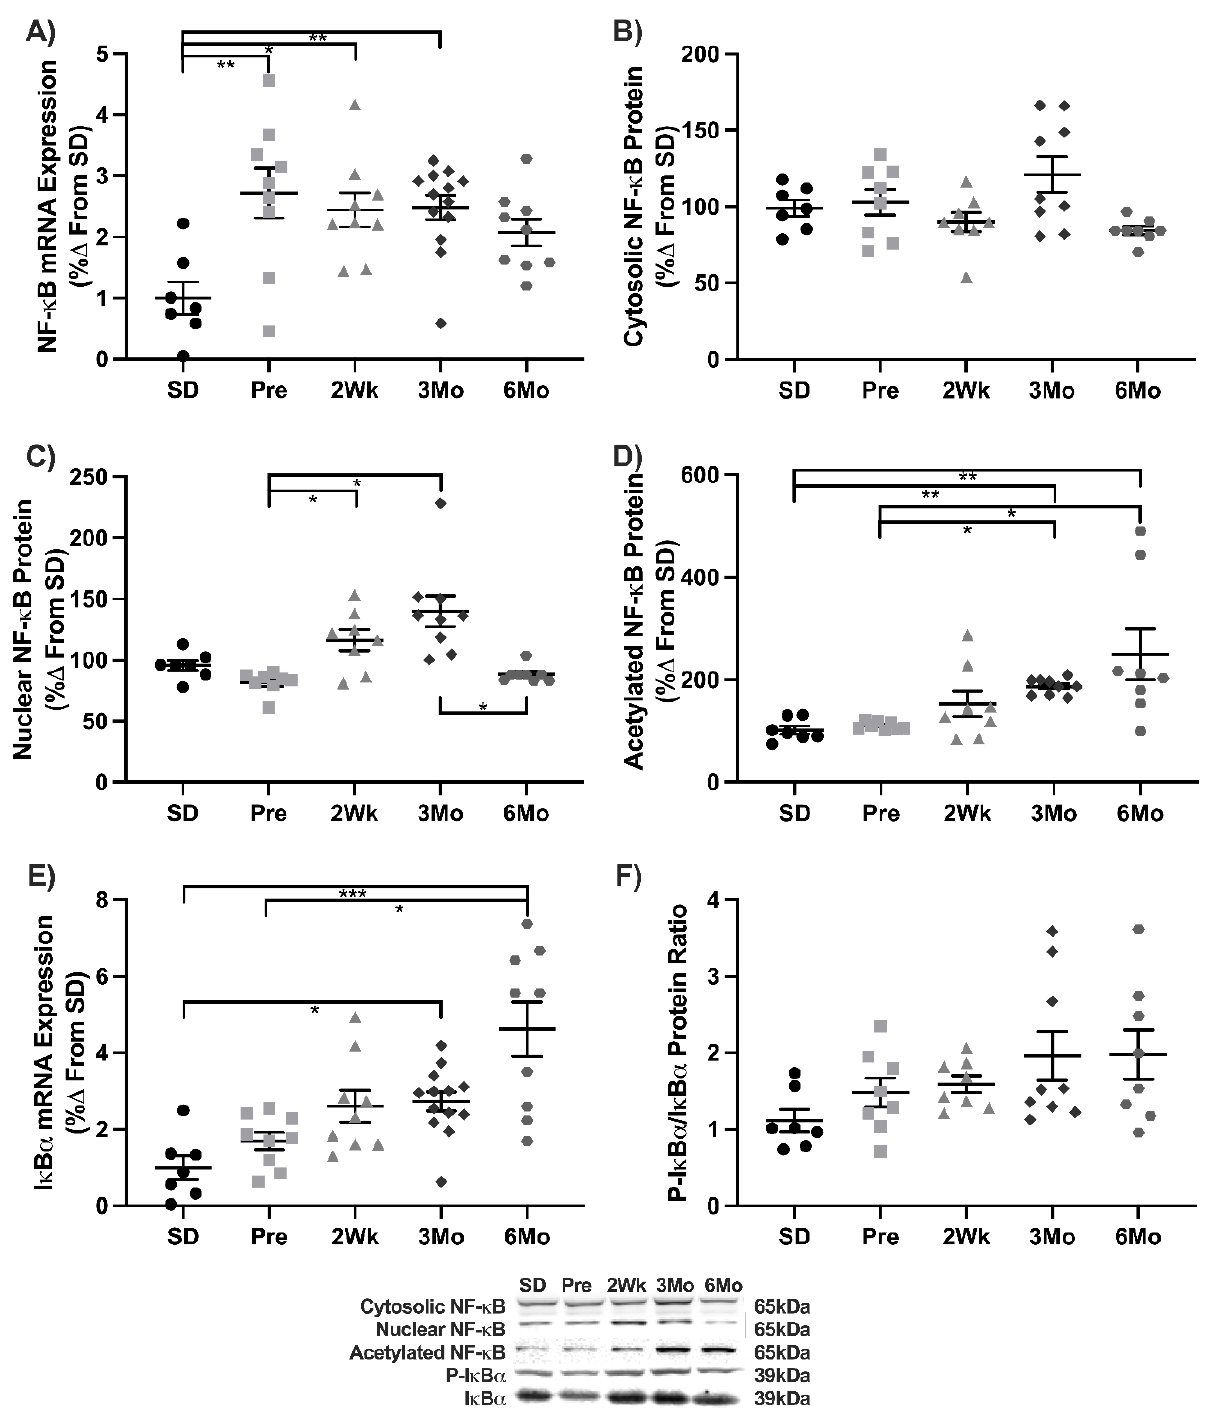
Figure 1. NF- κ B signaling during the progression of T2DM. Mean ± SEM values of ( A ) NF- κ B mRNA, ( B ) cytosolic NF- κ B protein, ( C ) nuclear NF- κ B protein, ( D ) acetylated Lys310 nuclear NF- κ B protein, ( E ), I κ B α mRNA, and ( F ) the ratio of phosphorylated to native I κ B α protein in Sprague-Dawley (SD; n = 7), pre-diabetic UCD-T2DM (Pre; n = 9), 2-week diabetic UCD (2Wk; n = 9), 3-month diabetic UCD-T2DM (3Mo; n = 13), and 6-month diabetic UCD-T2DM (6Mo; n = 9) rats. * p < 0.05, ** p < 0.01, *** p < 0.001.